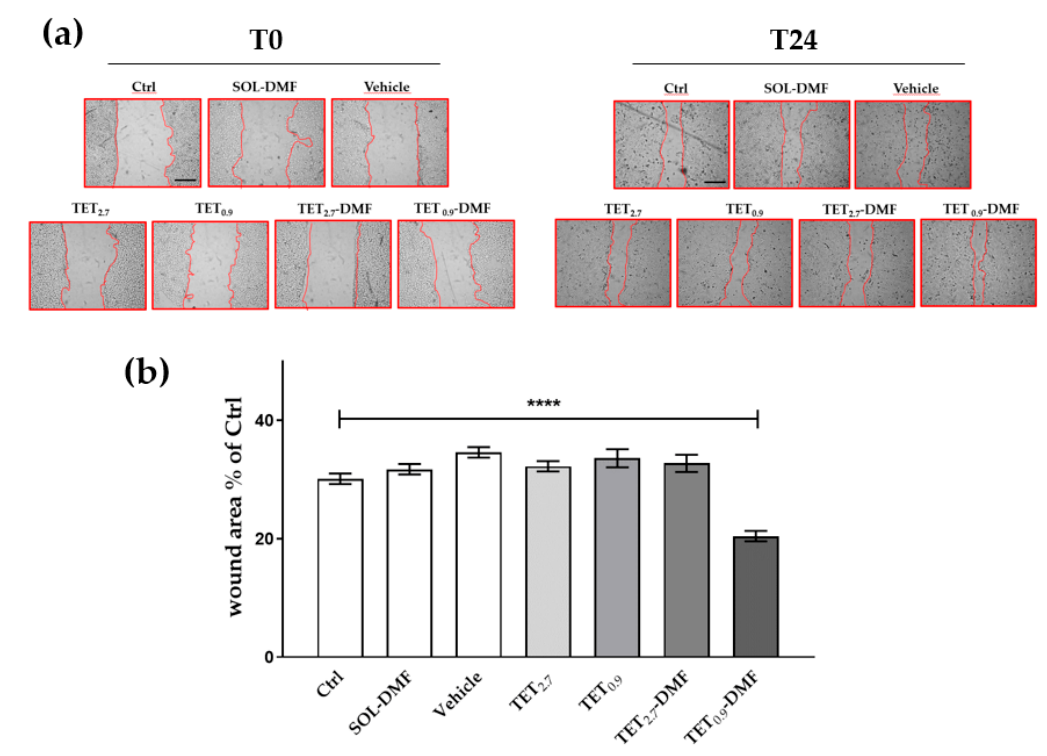
Figure 6. Effect of DMF-loaded or unloaded formulations on the wound closure in HaCaT cells: ( a ) a scratch test was performed on a confluent monolayer of HaCaT cells; different images were taken to measure the wound area right after the scratch (left panel T 0 ) and 24 h after (right panel T24) (scale bar 200 µm); ( b ) quantification of the wound area (within the red edges) 24 h after the scratch analysed by using ImageJ software, compared with T 0 . Data are the results of three independent experiments performed in triplicate. **** p ≤ 0.0001 using one-way ANOVA followed by Tukey’s multiple comparison test.